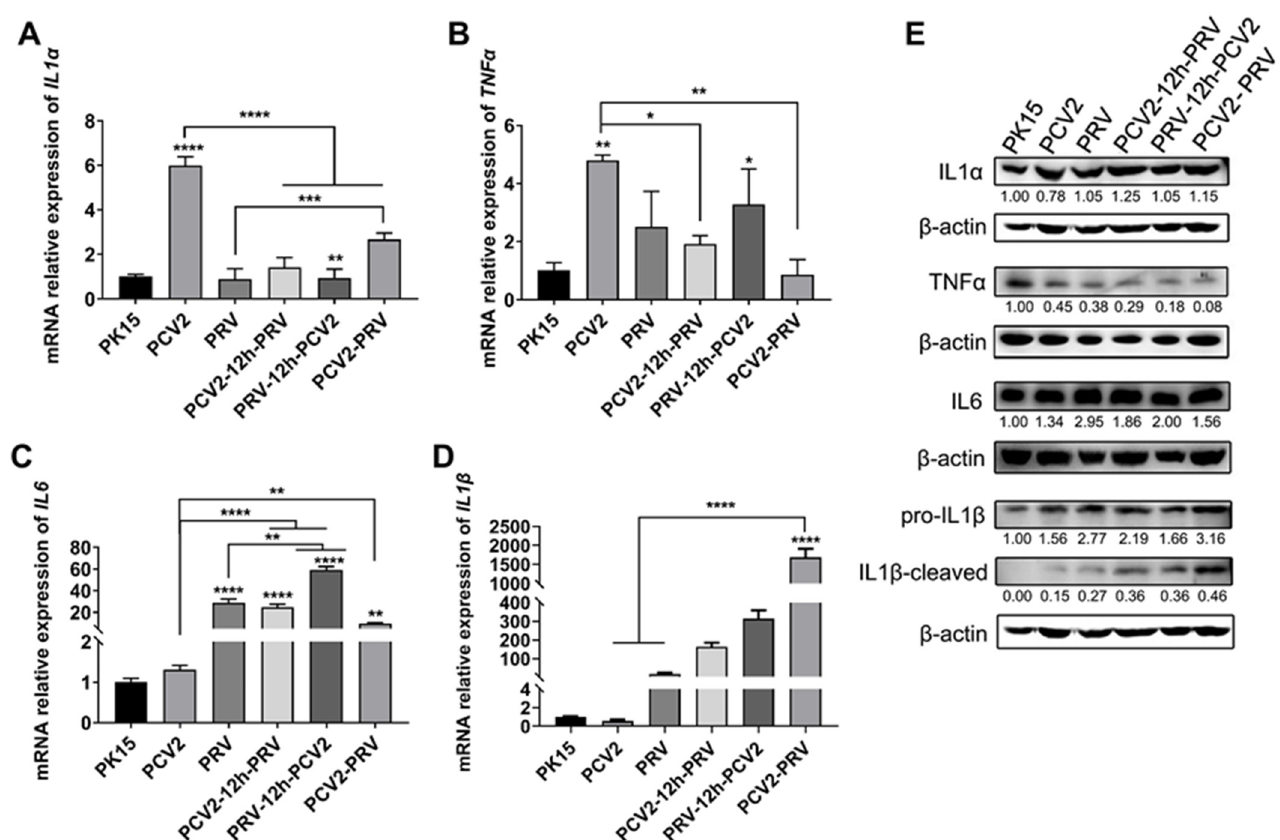
Figure 6. Coinfection of PCV2 and PRV modulates expressions of host pro-inflammatory factors. ( A – D ) Expression levels of pro-inflammatory factors. The relative mRNA levels of IL1 α ( A ), TNF α ( B ), IL6 ( C ), and IL1 β ( D ) were evaluated using real-time PCR. The data are presented as the means ± SD. *, p -value < 0.05; **, p -value < 0.01; ***, p -value < 0.001; ****, p -value < 0.0001. ( E ) Protein levels of pro-inflammatory factors. Western blotting was performed using IL1 α , IL1B Antibody, IL6, TNF α , and Anti- β -Actin Antibody as primary antibodies, respectively. HRP-labeled Goat Anti-mouse IgG (H+L) and HRP-labeled Goat Anti-rabbit IgG (H+L) were used as the secondary antibody. β -actin was used as a control. The average expression level of the target protein in each group is shown below each lane. The protein amount of the PK-15 group is set to 1, and the values of other groups are the ratio with the PK-15 group. Unprocessed original images can be found in Supplementary Figure S5.